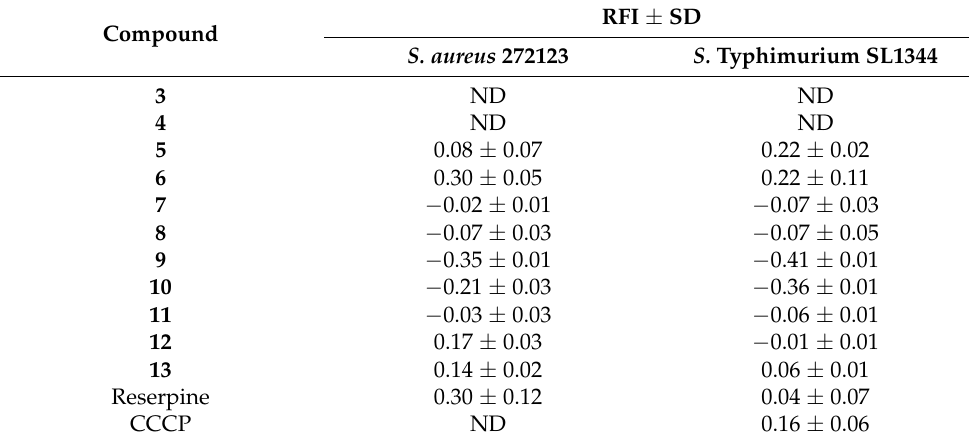
Table 2. RFI of tested